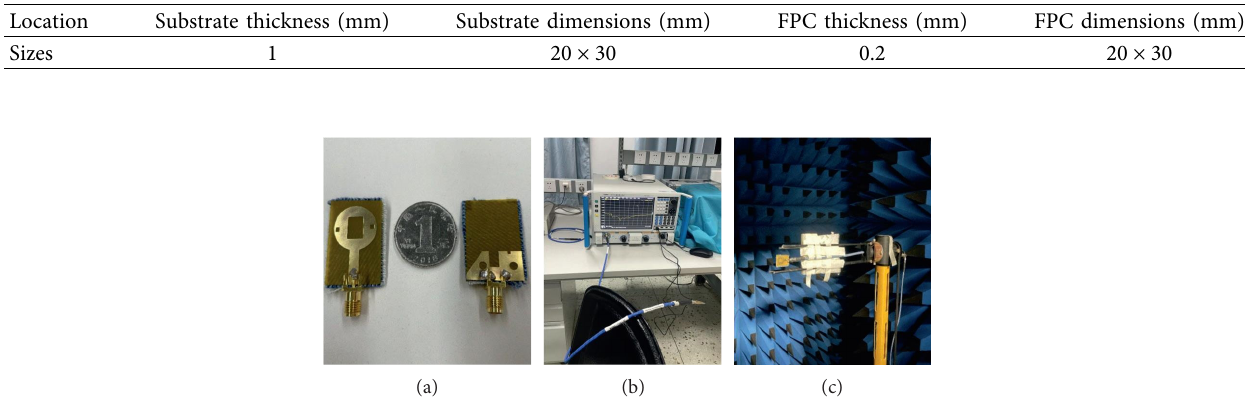
Table 2: Dimensions of the designed wearable UWB antenna.